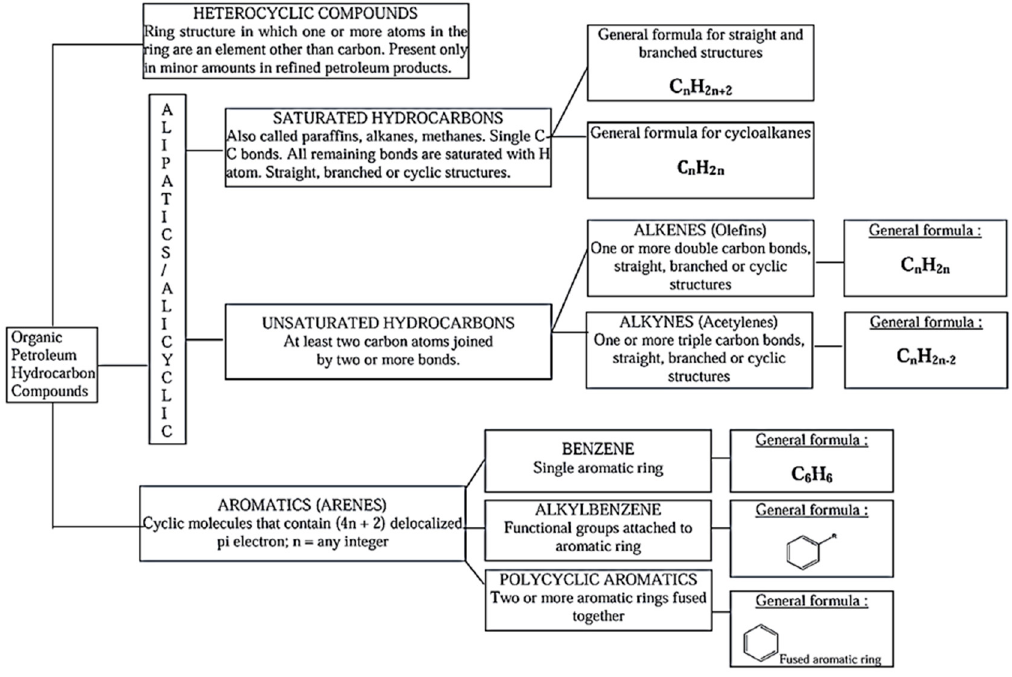
Figure 1. Summary of the different categories and subclasses of total petroleum hydrocarbons. Adapted and modified from Hidayat and Turjaman [11].